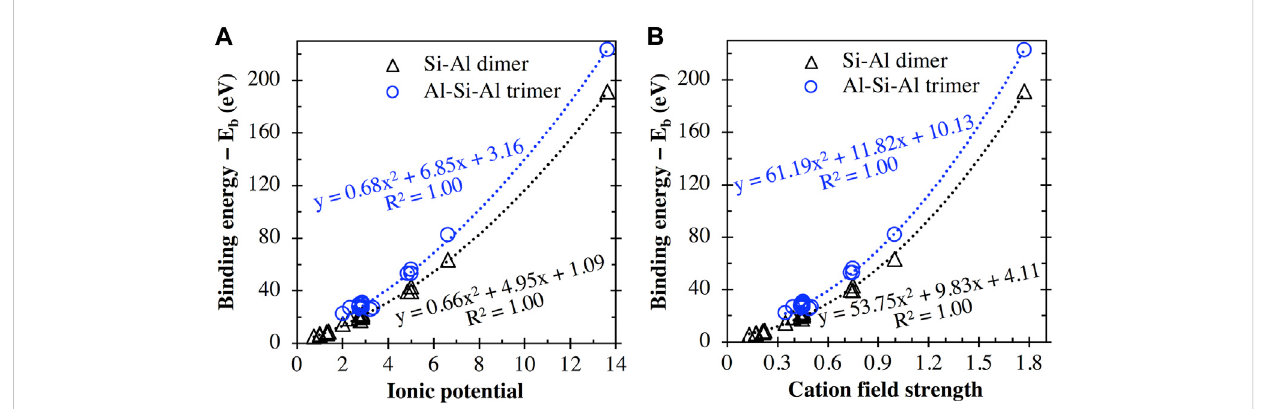
FIGURE 9 Comparison of the cation binding energies (including cation + OH clusters) with the aluminosilicate dimer and trimer with (A) the ionic potential (i.e., charge/effective ionic radius) and (B) the fi eld strength (see Eq. 2) of the metal cations. Data have been fi tted using 2nd order polynomial functions, where the equations of best fi t and corresponding R 2 values are provided.